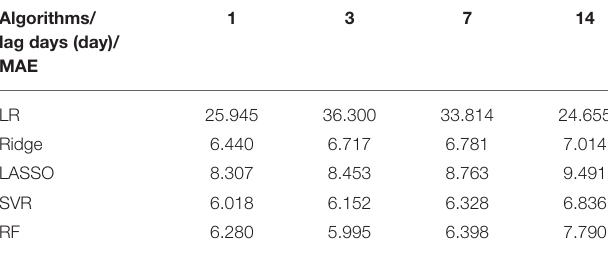
TABLE 3 | Mean predictive performance of different algorithms for the OPHS number. Algorithms/ lag days